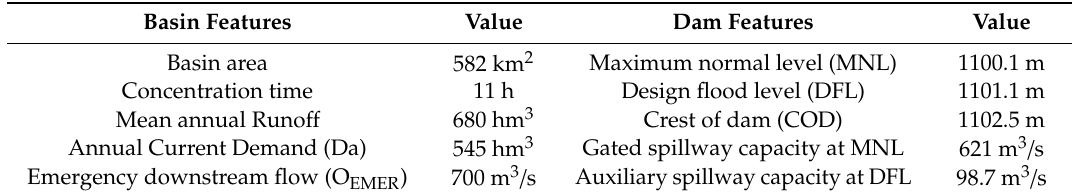
Table 1. Main characteristics of the Riaño basin, dam, and